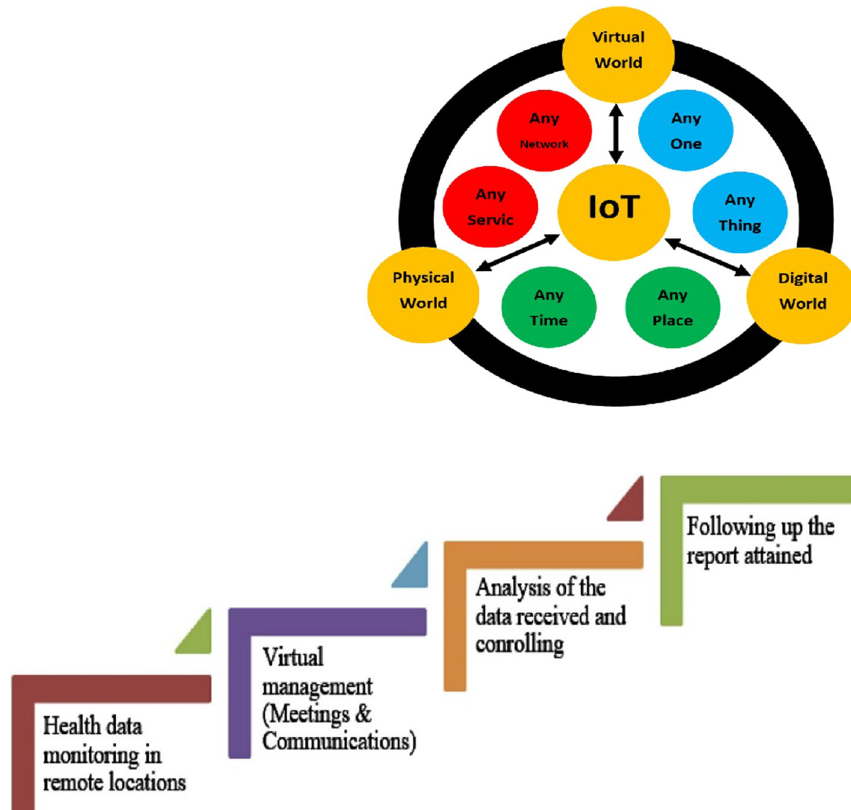
Fig. 1 IoT Concept Ghasem- pour [11]